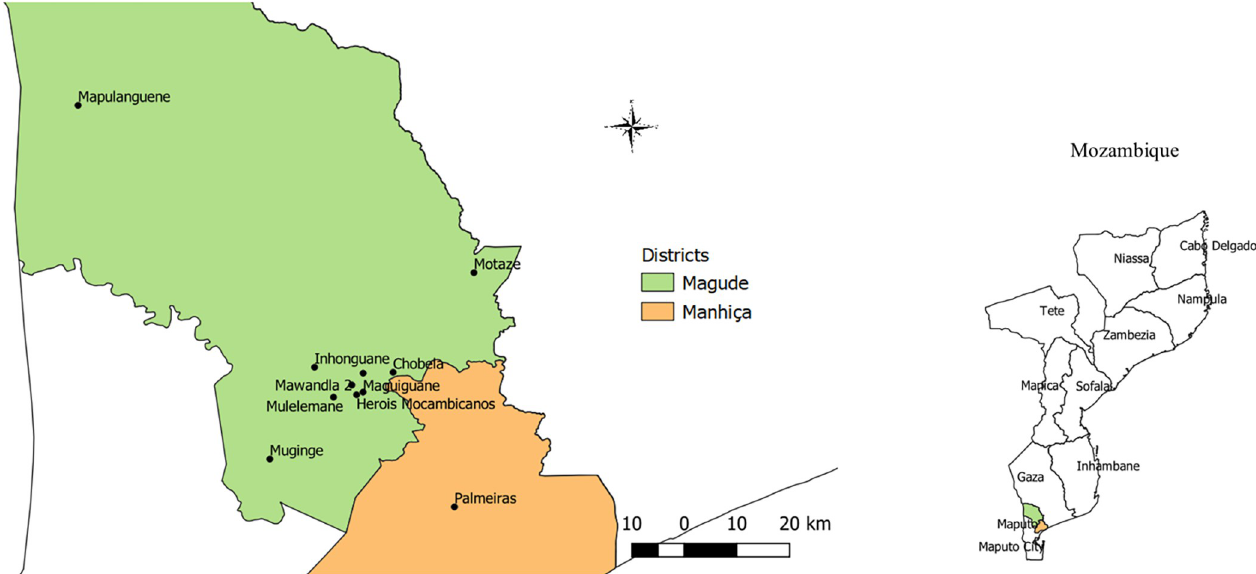
Fig 1. Map of the study areas. Villages/neighborhoods in Magude and Manhic¸a districts where adult mosquitoes were collected for insecticide resistance monitoring and/or WHO cone bioassays to evaluate the residual efficacy of Actellic 1 300CS. The subnational administrative boundaries were obtained from the Humanitarian Data Exchange (https://data.humdata.org/dataset/cod-ab-moz) under a CC-BY-IGO license (https://data.humdata.org/faqs/licenses).